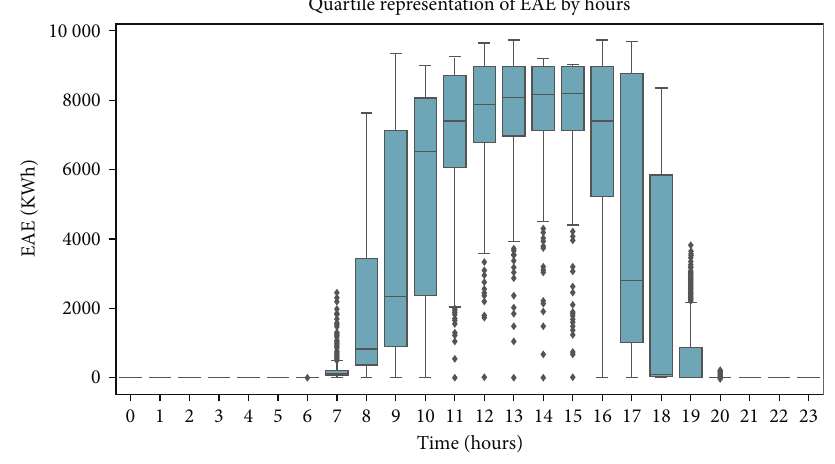
Figure 8: Distribution of EAE in hours of the day. Table 2: Metric results by number of neurons. #Neurons Corr. coe ff Det. coe